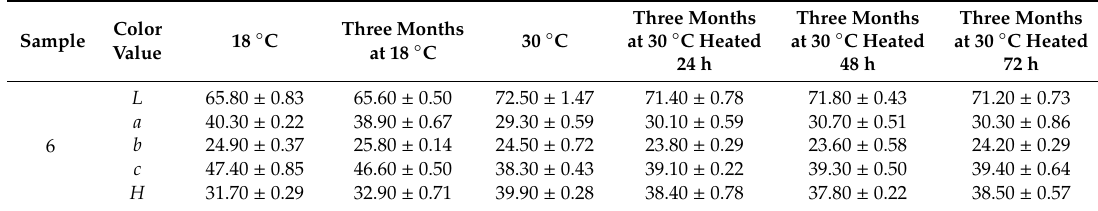
Table 11. E ff ect of time on color value of discoloration coating.